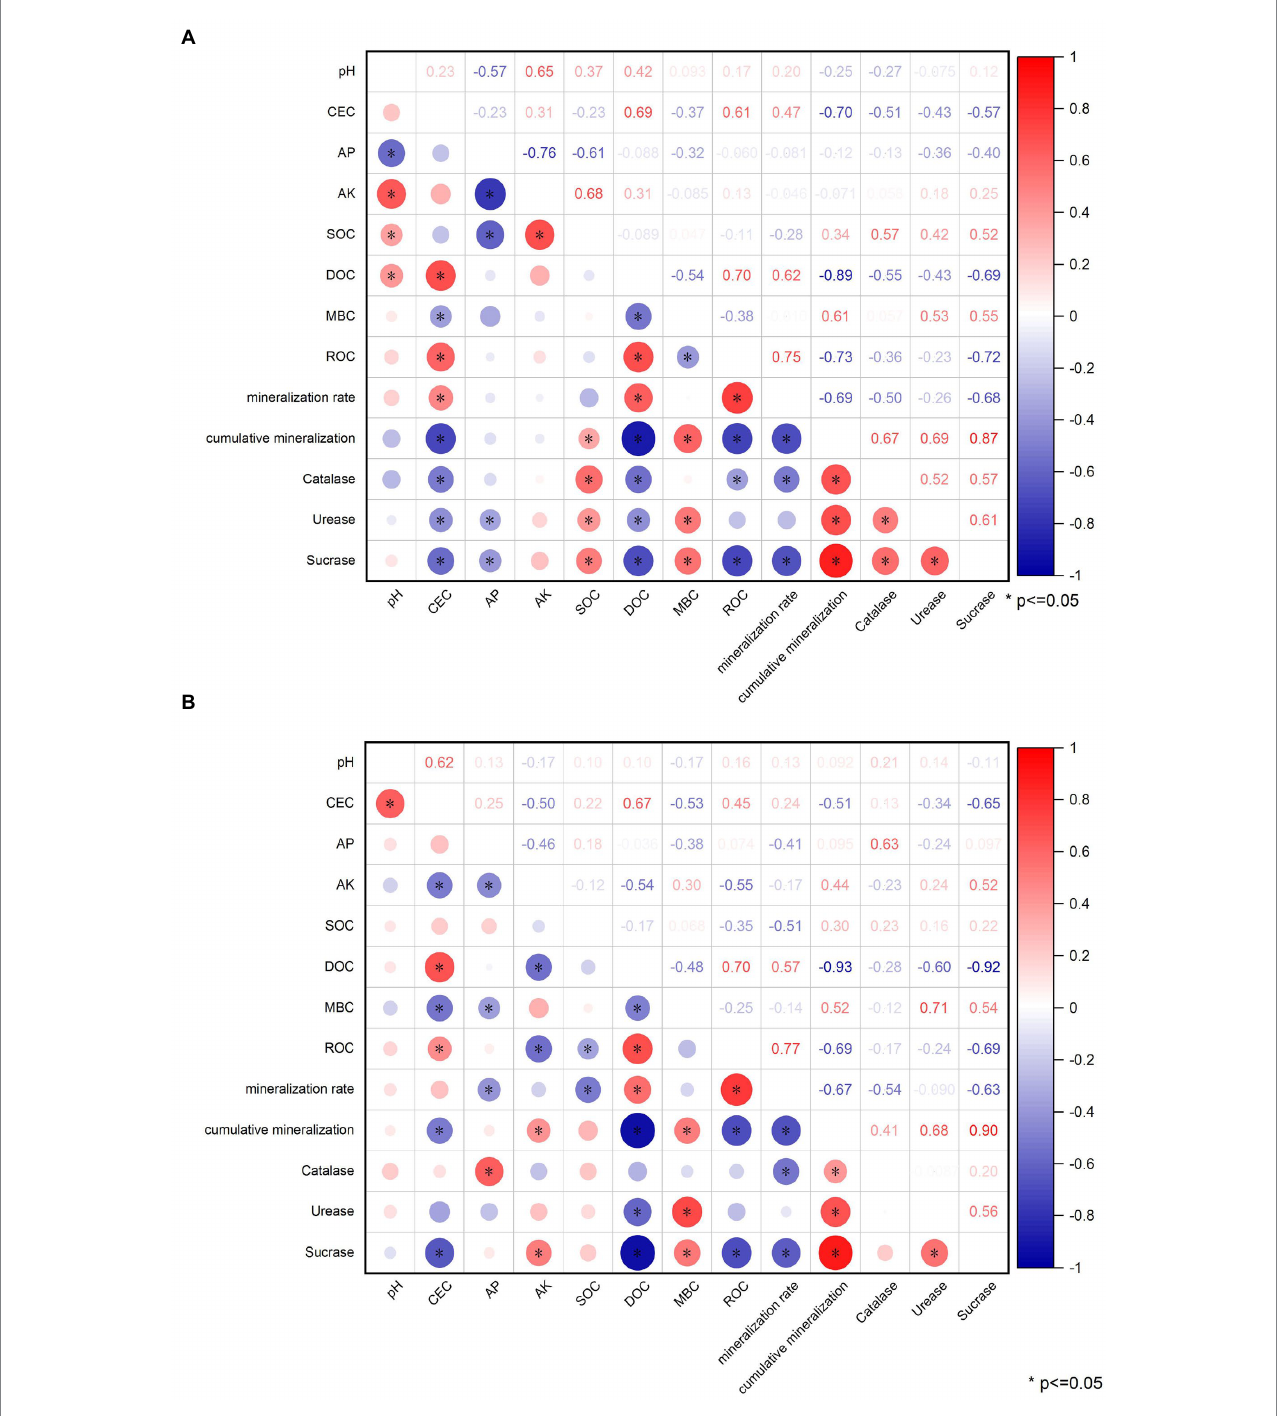
FIGURE 15 Correlation between physical and chemical properties, carbon composition, enzyme activity and mineralization of (A) OBC-Mg and (B)